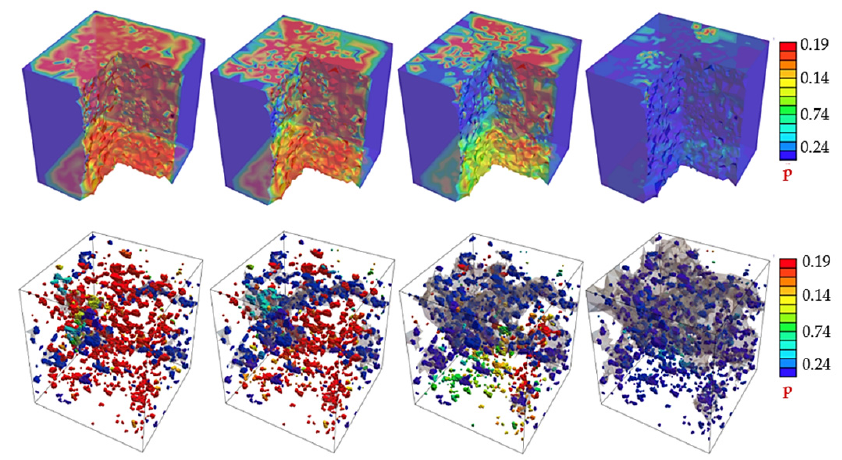
Figure 8. Pressure field p for the microscopic concrete specimen with different deformation states.